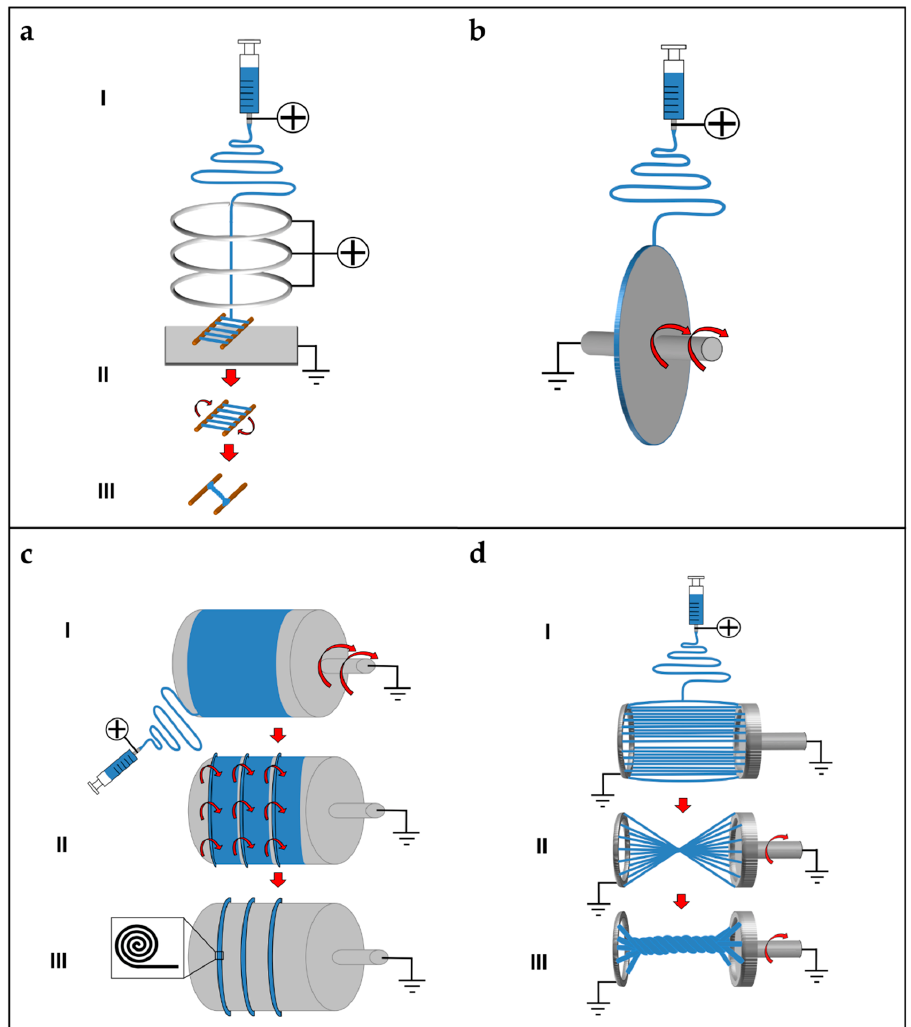
Figure 5. Different electrospinning setups to produce short yarns or bundles of nanofibers. ( a ) Short yarns production by three collimators rings: (I) the nanofibers travel through three metallic rings charged with the same polarity of the needle; (II) the nanofibers are aligned on two parallel wooden rods placed between the last ring and a flat plate ground collector; and (III) the mat of aligned nanofibers is manually twisted to obtain a short yarn [154,155]. ( b ) Tapered edge disk collector to produce short bundles of nanofibers [156]. ( c ) Finite length bundles production setup: (I) Nanofibers electrospin on a high-speed rotating drum collector to obtain aligned nanofibers; (II) the mat cut in strips which are manually wrapped on the drum; and (III) final bundles on the drum before being cut (box: schematic of a cross-section of a bundle) [59,60,93]. ( d ) Finite length yarns production with small discs setup: (I) solution electrospins on two parallel small metallic ground discs to obtain aligned nanofibers; (II) after the electrospinning session, one of the discs is put in rotation to twist the nanofibers; and (III) final yarn produced between the discs [162].